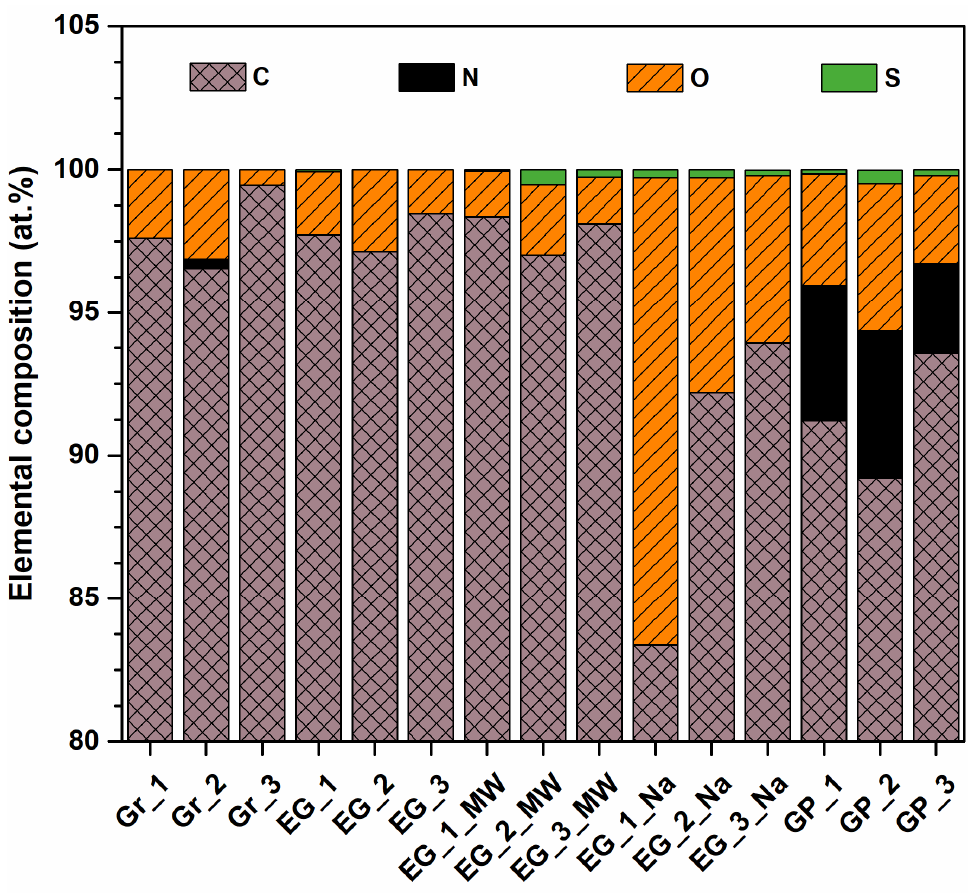
Figure 5. Surface elemental composition of pristine graphite and EG and nanocomposite samples determined by XPS analysis.